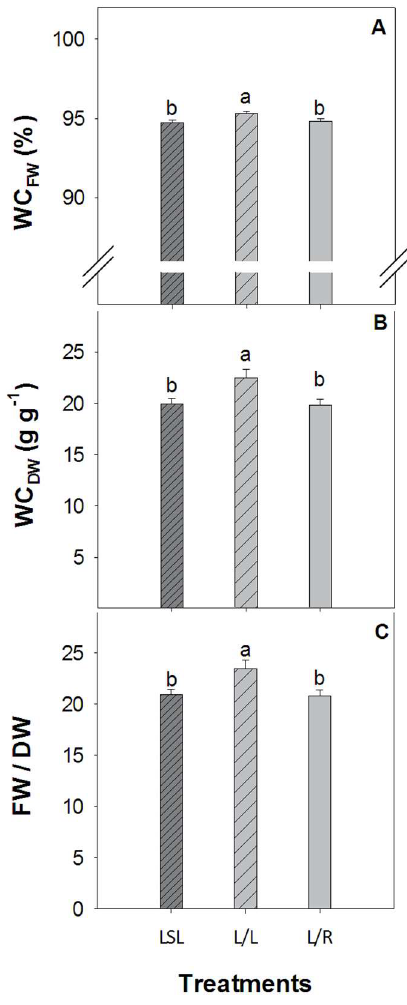
Figure 7. Water content on a fresh (WC FW , %) weight basis ( A ), water content on a dry (WC DW , gg −1 ) weight basis ( B ) and ratio fresh weight to dry weight (FW/DW) of the fruit ( C ) by treatments LSL (long-shelf-life tomato), L/L (self-grafted Old Limachino tomato) and L/R (grafted Old Limachino tomato on Poncho Negro rootstock) under greenhouse conditions. Each value represents the mean ± SE ( n = 12). Lower-case letters indicate differences ( p ≤ 0.05, Duncan test) among treatments.